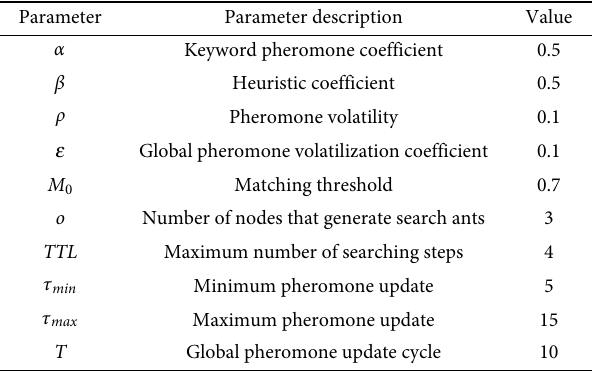
Table 1 Parameter configuration of search algorithms based on ant colony algorithms.